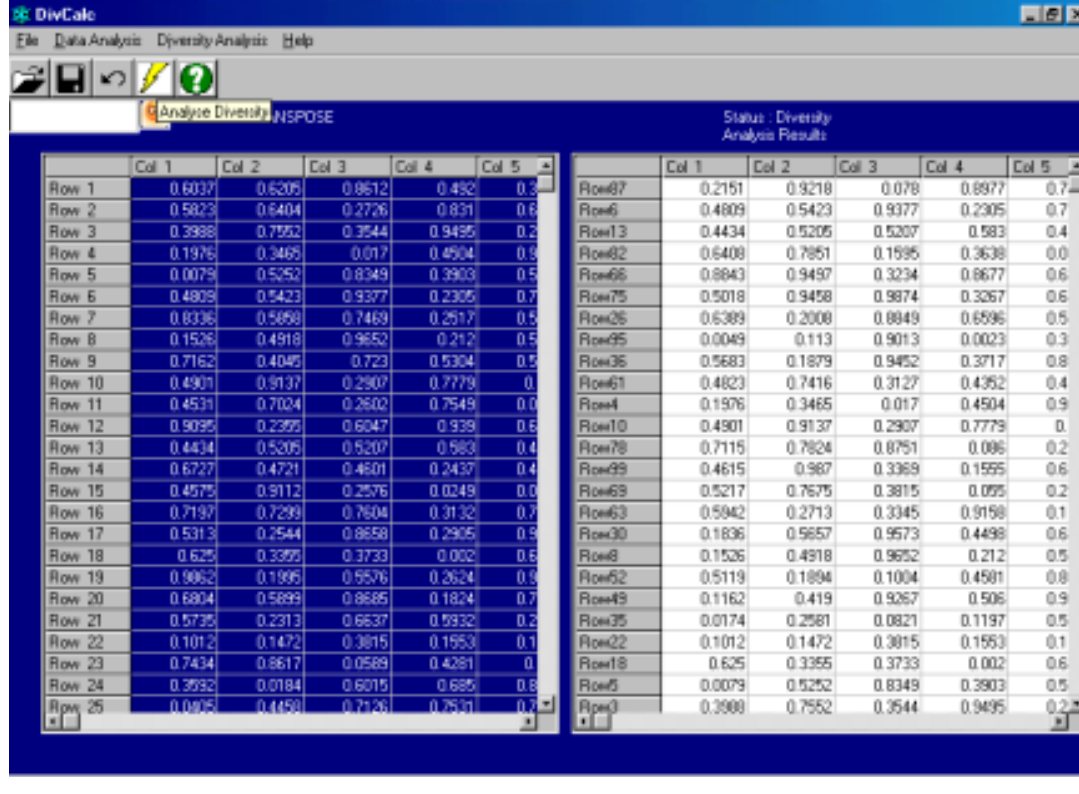
Figure 3. Diversity Analysis